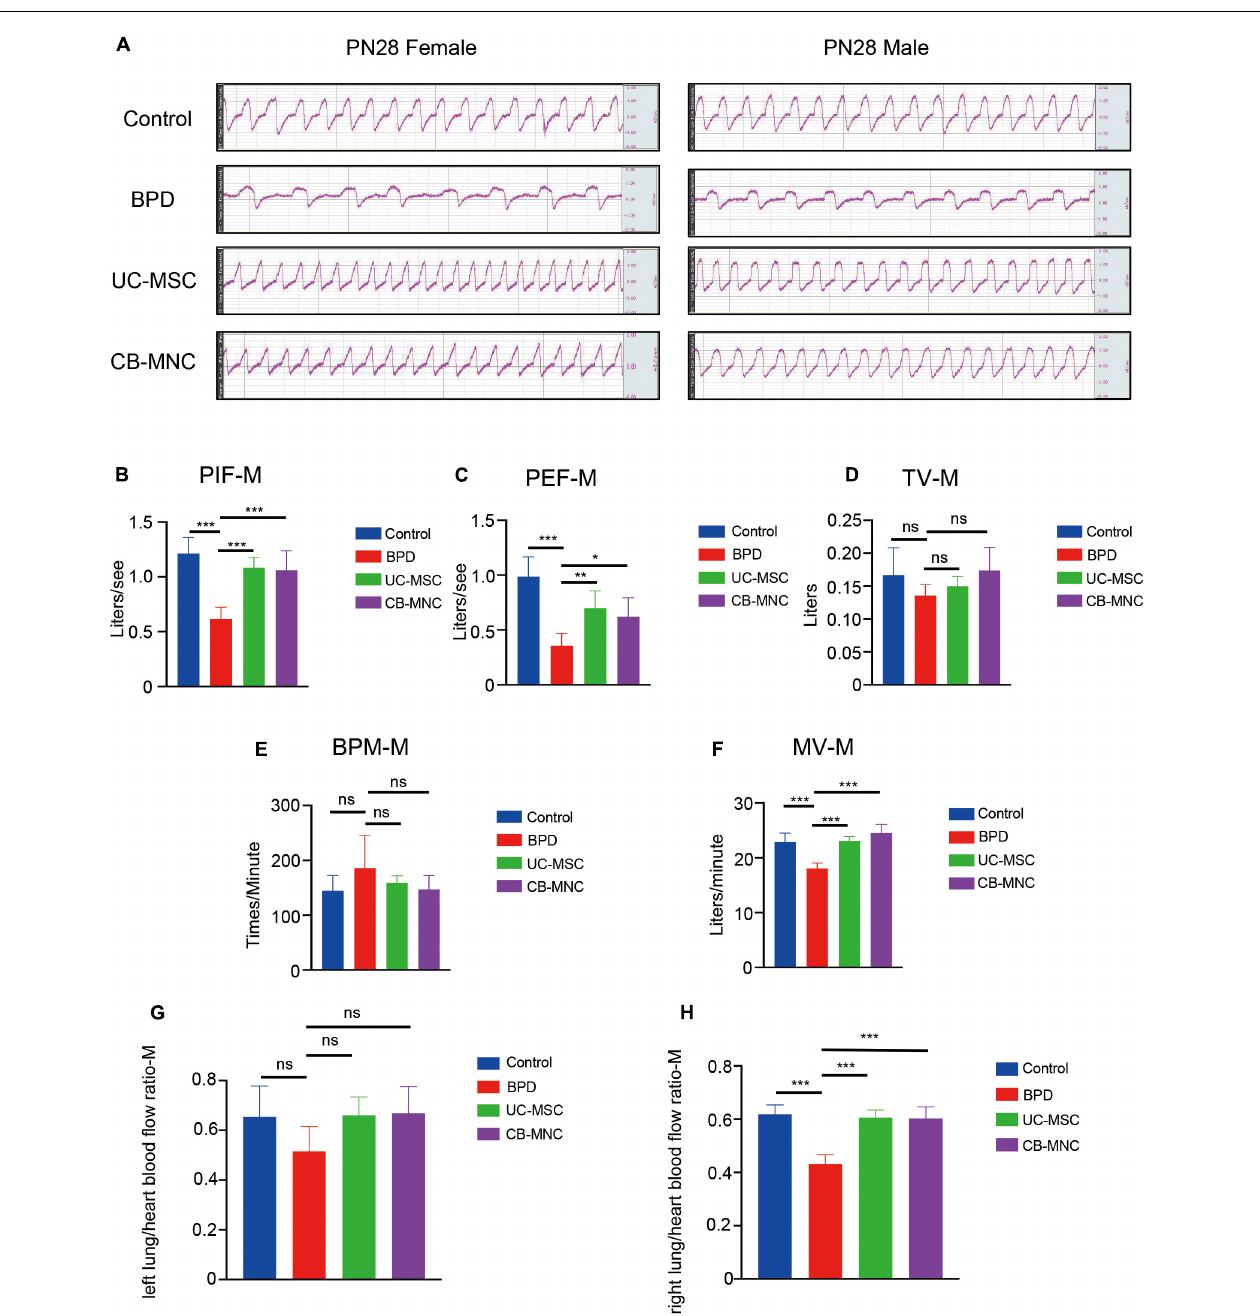
FIGURE 5 | Intravenous infusion of CB-MNCs and UC-MSCs improved pulmonary respiratory function and pulmonary vessel circulation. (A) Representative respiratory waveforms of male and female mice at postnatal day (PN)28 after indicated treatments. (B–F) Pulmonary function testing among male mouse groups. The indicators include peak inspiratory flow (PIF) (B) , peak expiratory flow (PEF) (C) , tidal volume (TV) (D) , breathing per minute (BPM) (E) , and minute volume (MV) (F) . Values are mean ± SD of a minimum of six animals in each group,*p < 0.05, **p < 0.01, ***p < 0.001, by one-way ANOVA test). (G,H) Bar graph showing lung/heart blood flow ratio analysis of pulmonary vascular function in different groups at indicated time points. (G) Left side, (H) right side. Values are mean ± SD of a minimum of six animals in each group, *p < 0.05, **p < 0.01, ***p < 0.001, by one-way ANOVA test.